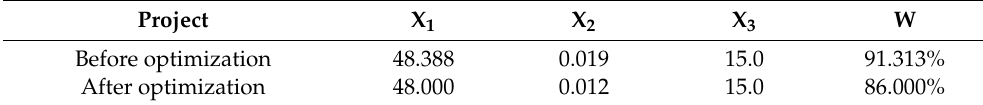
Table 5. Comparison of optimization results with actual